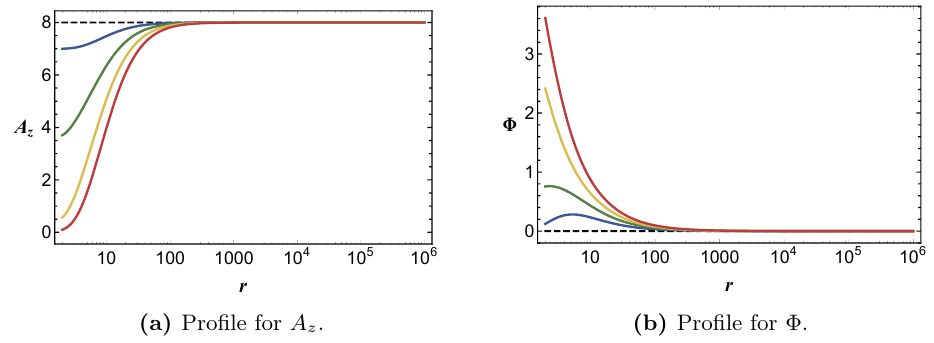
Figure 3. (a)-(b): pro(cid:12)les for A z and (cid:8) where we (cid:12)x b = 8 and T = 2 =(cid:25) . We use M = 0, 3 : 3 ; 5 : 5, 7 : 5, 9 : 7 for (cid:13)at-dashed, blue, green, yellow, red (from top to bottom in (a) and from bottom to top in